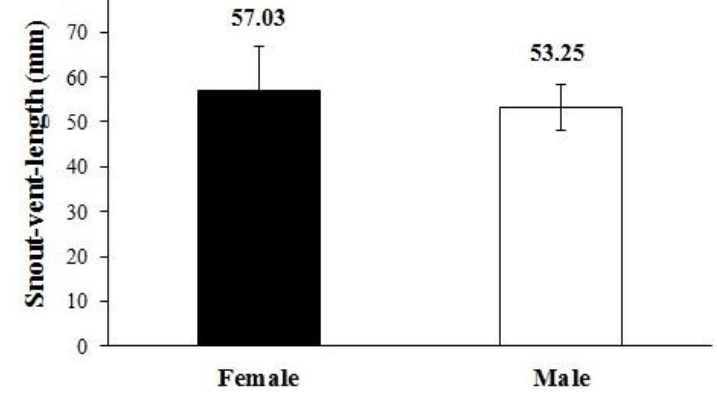
Fig.1. The snout-ventral length (SVL ± SE) in male and female of D.